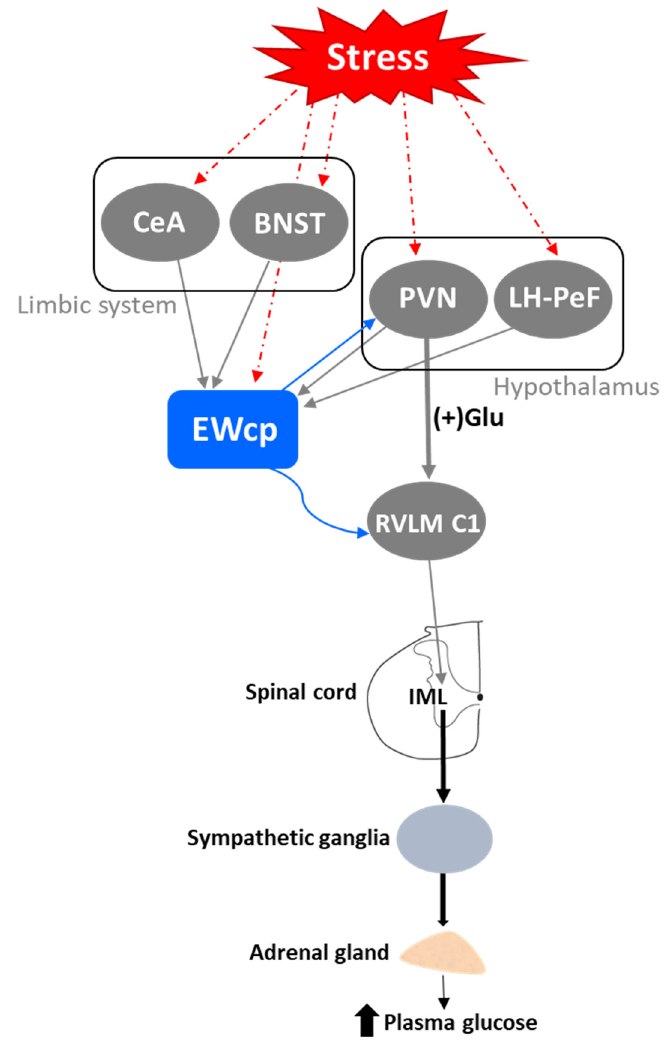
Figure 5. Connections of EWcp with the circuit involved in stress-induced hyperglycemia. Glutamatergic inputs from PVN excite RVLM C1 neurons, inducing glucose mobilization via projections to the spinal cord that activate the adrenal gland (adrenalectomy completely blocks hyperglycemia). EWcp, which is activated by stress, is part of the central circuit that controls the sympathetic outflow to the adrenal gland. EWcp receives projections from limbic and hypothalamic regions that are activated by stress. For terms, see the list of abbreviations.